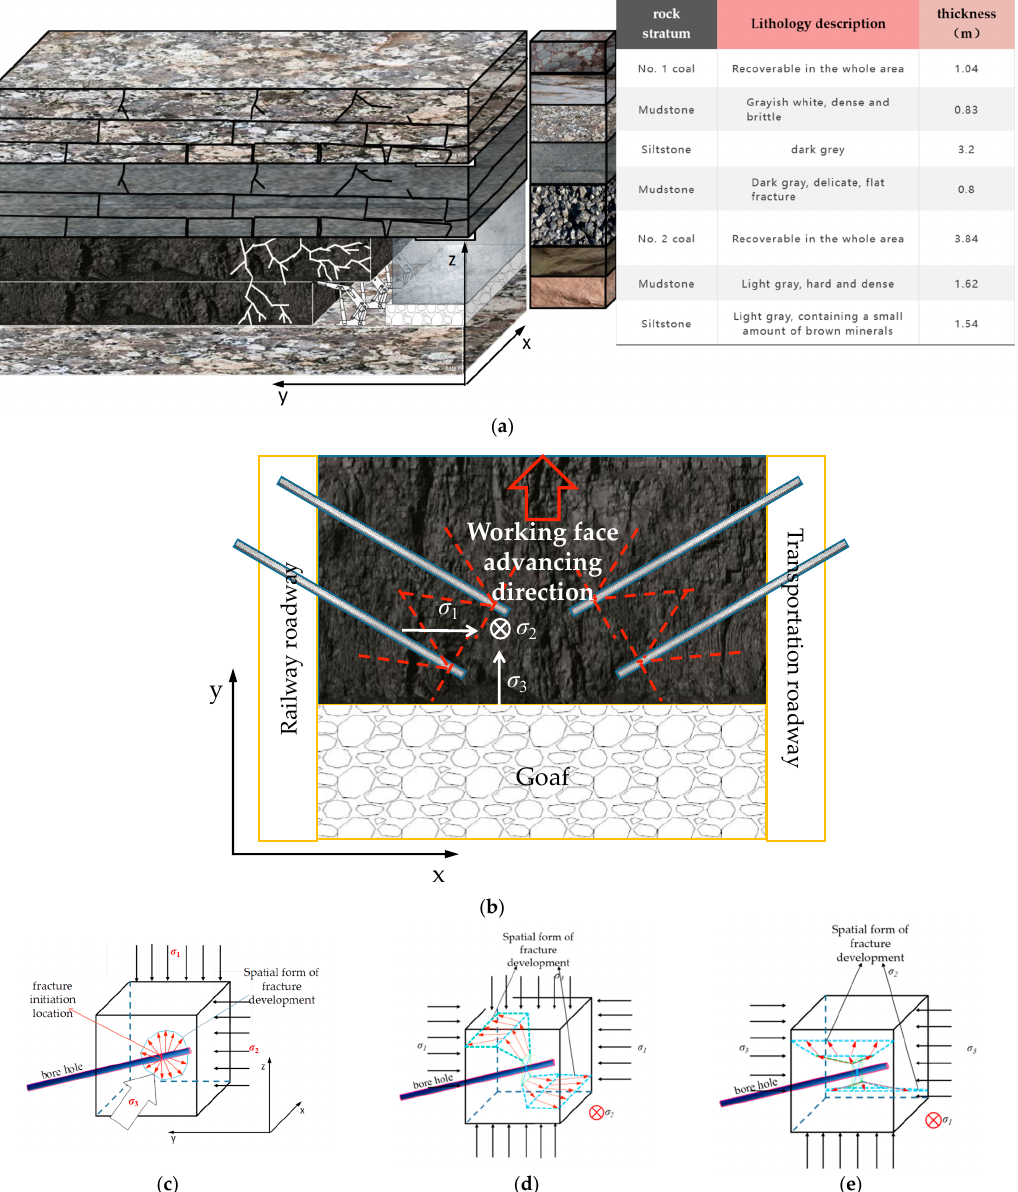
Figure 1. Relationship between the spatial development pattern of the deep-hole hydraulic-fracturing fractures and the evolution of the in situ stress types. ( a ) Comprehensive geological histogram. ( b ) The spatial relationship between the layout of the long-hole hydraulic-fracturing drilling site and the stope roof in the advance roadway ( σ V is the vertical maximum principal stress; σ H is the maximum horizontal principal stress; and σ h is the minimum horizontal principal stress); the red dotted line is the possible jet direction when the high-pressure water-jet drill pipe is used to induce the kerf. ( c ) Type I geostress. ( d ) Type Ⅱ geostress. ( e ) Type III geostress.